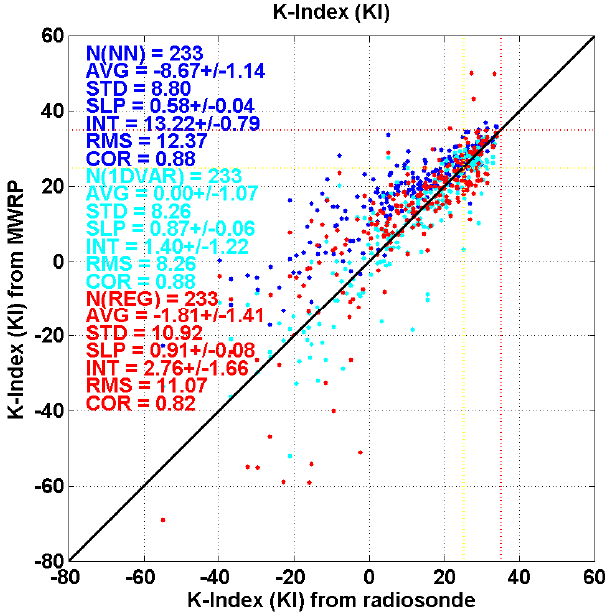
Figure 10. Scatter plot of K index values computed from ra- diosonde and MWRP-retrieved profiles (NNz in blue, 1-DVAR in cyan, REG in red) and respective statistics: average (AVG), standard deviation (SD), and root-mean-square (rms) differences, correlation coefficient (COR), slope (SLP) and intercept (INT) of a least-square linear fit. AVG, SD, INT, and rms are in kelvin. SLP and COR are unitless. Numbers after the ± sign indicate the 95% confidence in-